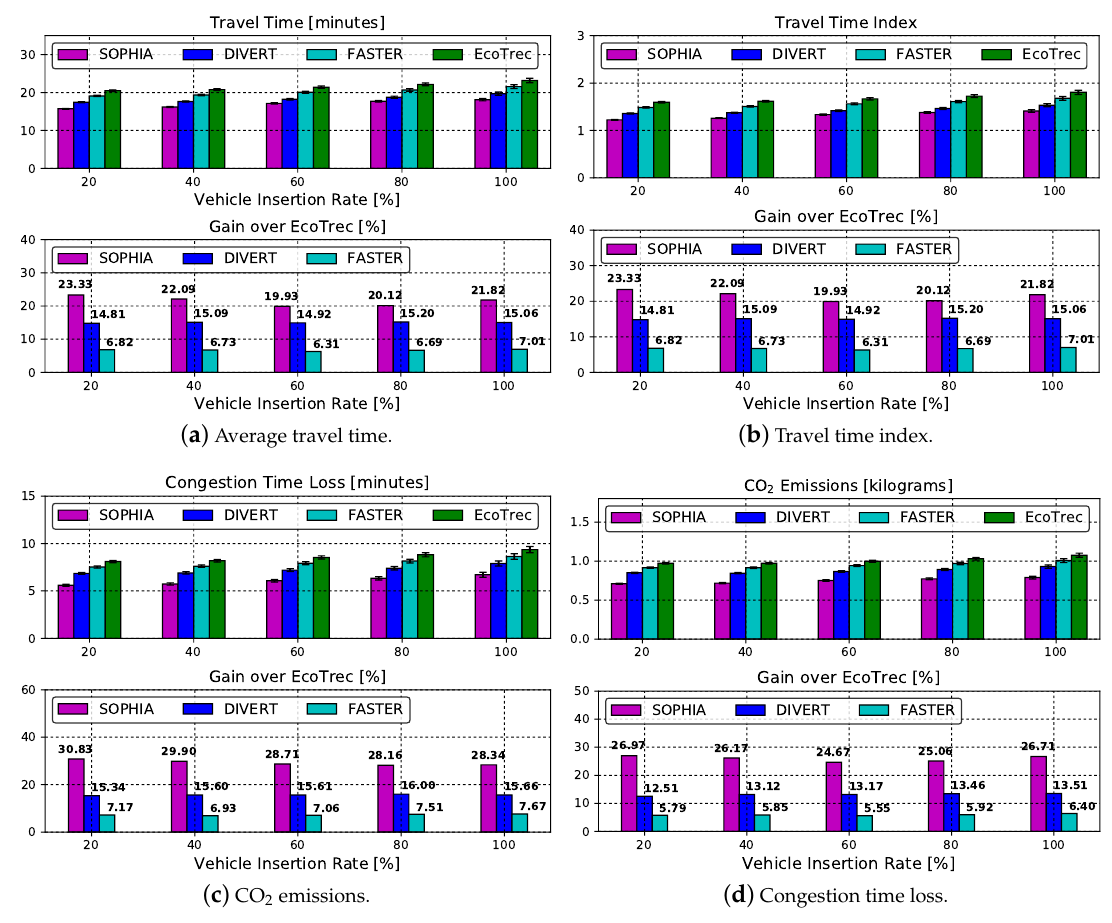
Figure 6. Traffic Management